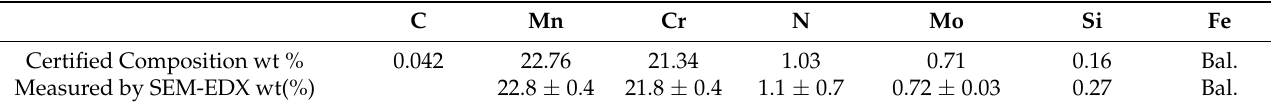
Table 1. Chemical composition, in wt%, of Biodur 108©